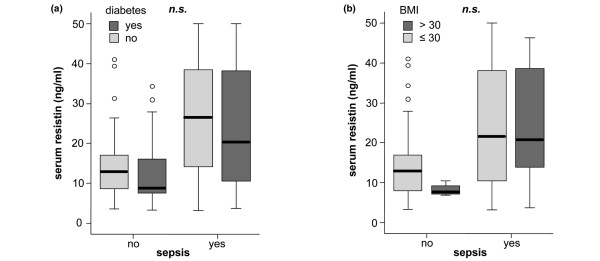
Association of serum resistin with diabetes and obesity in critically ill patients. (a) Serum resistin levels do not differ between patients with or without pre-existing diabetes mellitus. (b) Serum resistin levels are not associated with obesity as defined by a body mass index of more than 30 kg/m2. Box plots are displayed, where the bold black line indicates the median per group, the box represents 50% of the values, and horizontal lines show minimum and maximum values of the calculated non-outlier values; open circles indicate outlier values. ns = not significant.